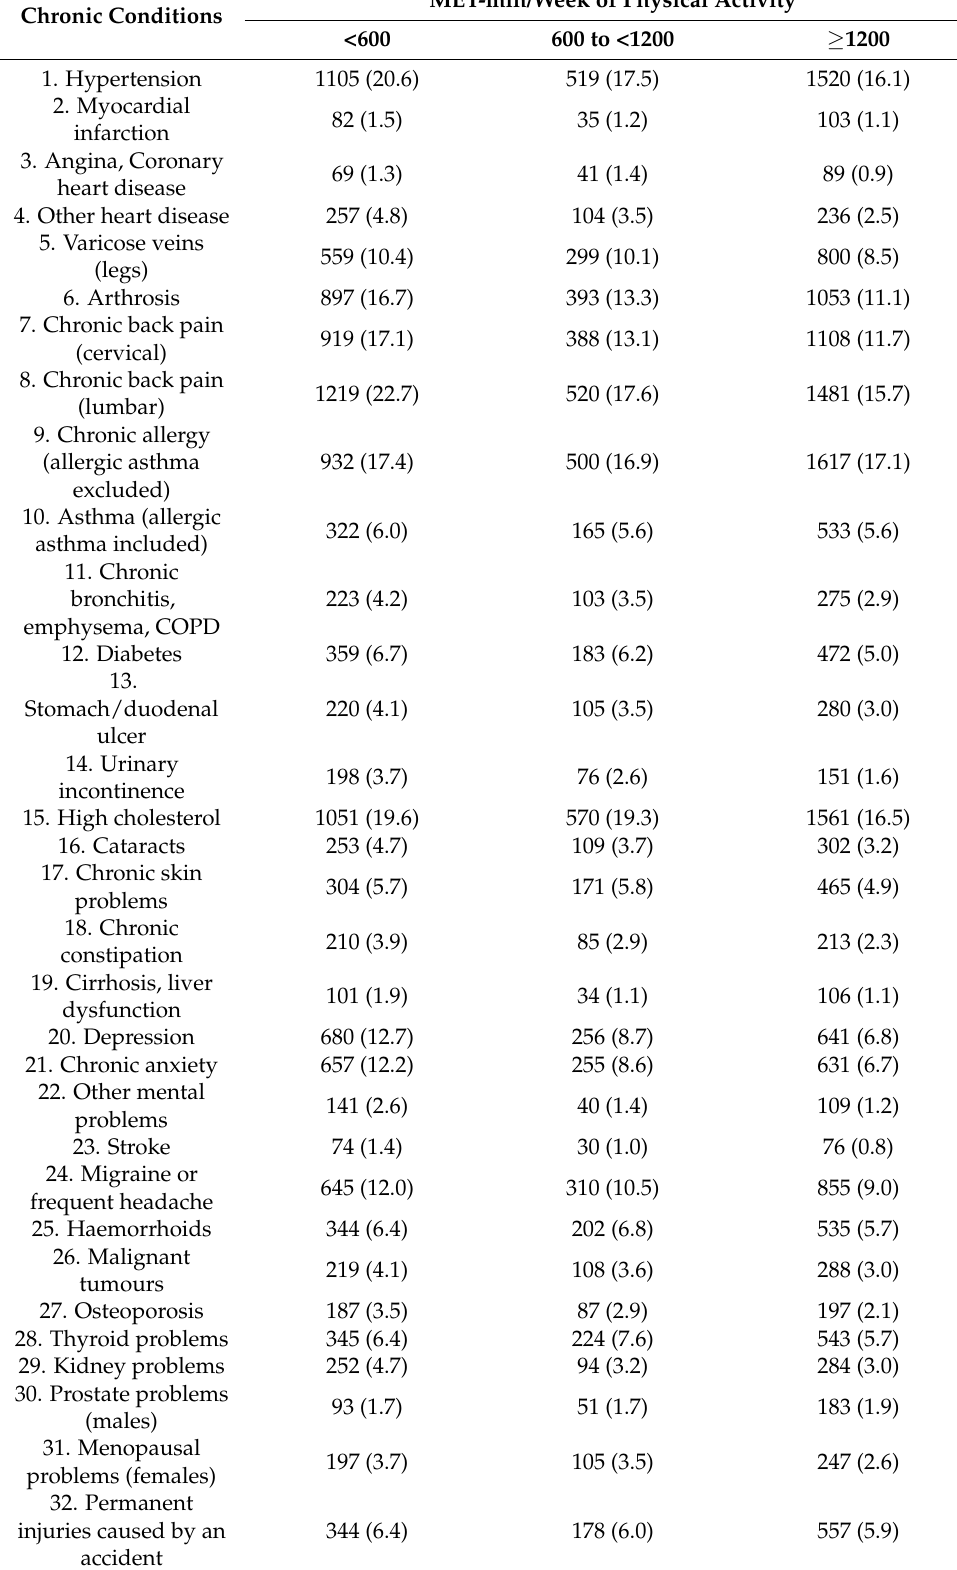
Table 1. Prevalence of chronic conditions in Spanish adults by physical